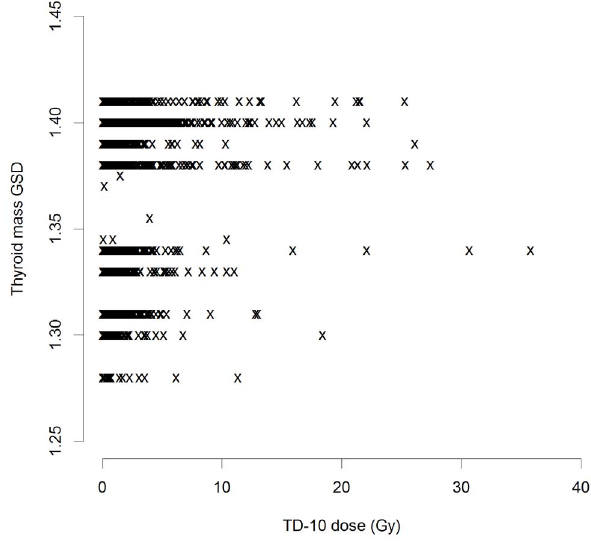
Figure 2. Distribution of the geometric standard deviation (GSD) of errors associated with assessments of thyroid activity GSD as a function of TD-10 thyroid dose. Low dose range.